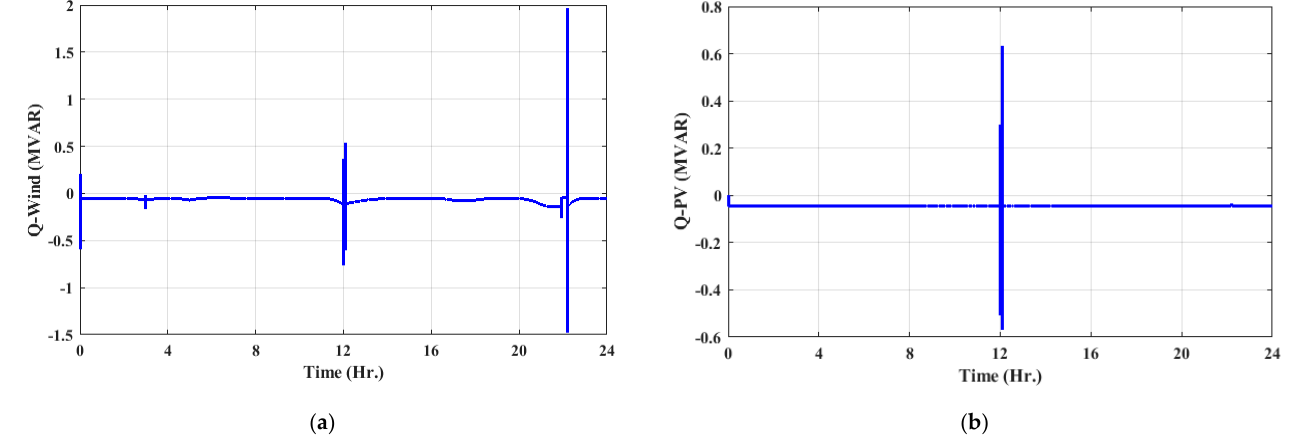
Figure 10. Generated reactive power: ( a ) Wind farm reactive power and ( b ) PV reactive power.